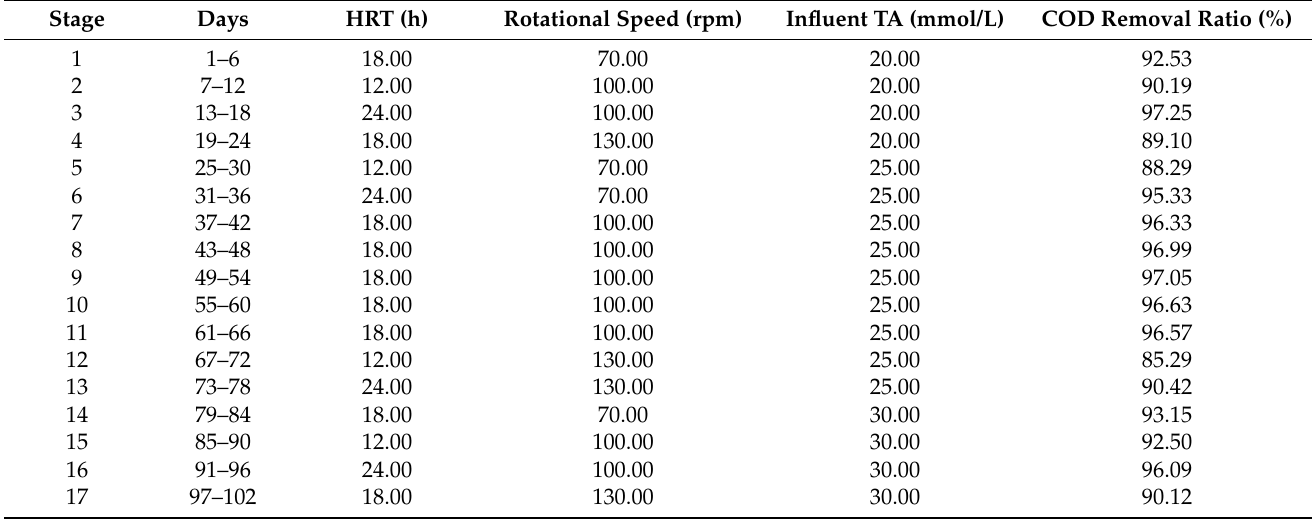
Table 1. Box–Behnken experimental design and the corresponding